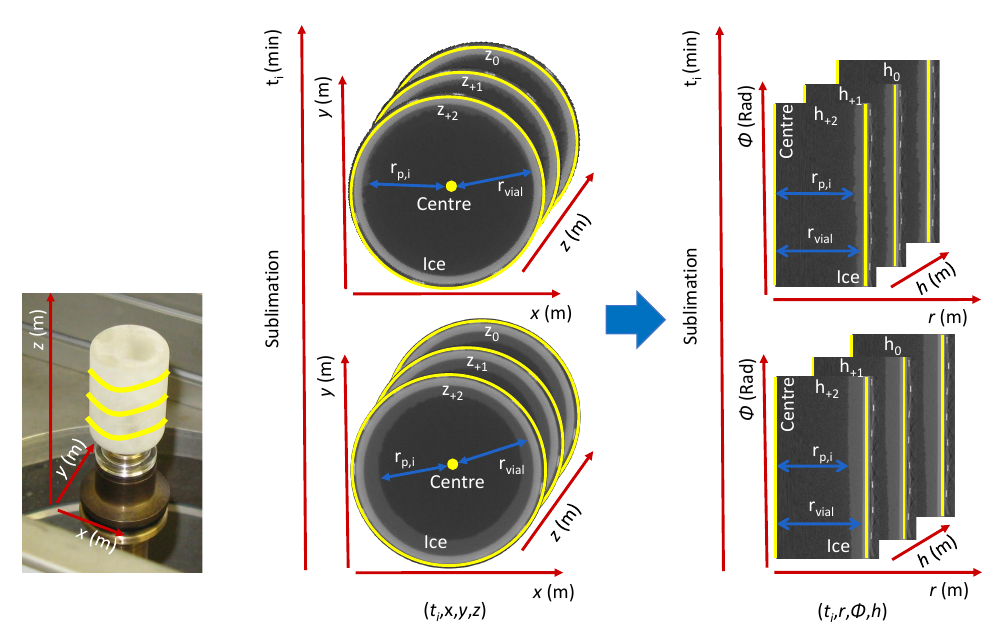
Figure 3. Conversion of the data structure from a cartesian coordinate system (x,y,z) (middle section) to a cylindrical coordinate system ( r , Φ , h ) (right section) for each time point t i , (i.e., each